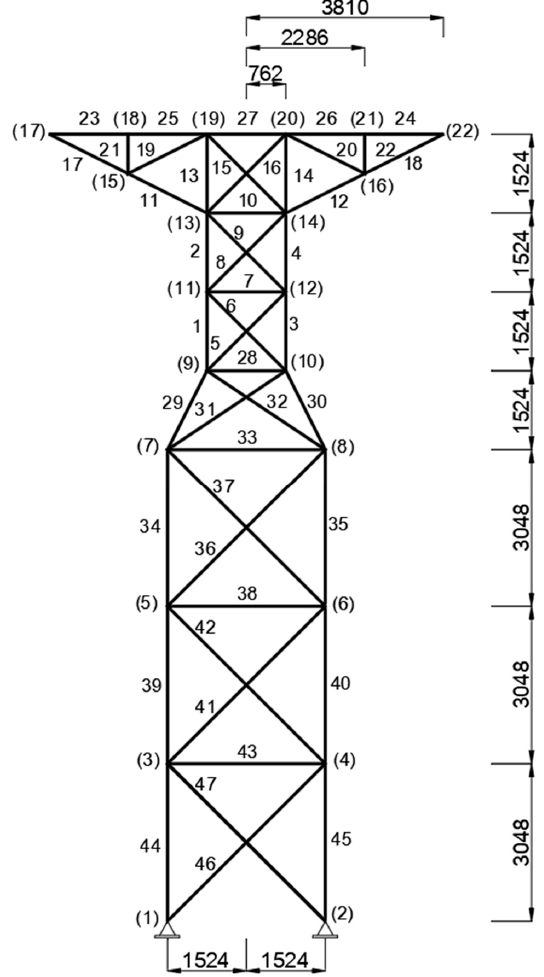
Figure 13. Layout and geometry of the 47-bar power line.